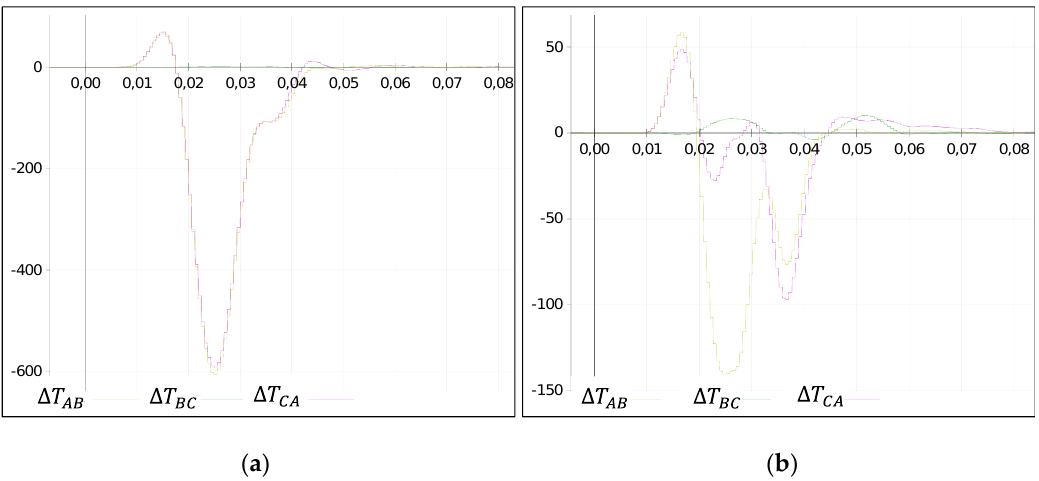
Figure 6. Instantaneous values of scalar products based on superimposed quantities theory for AG fault when current contribution comes from SG ( a ) or Type 4 WT ( b ).